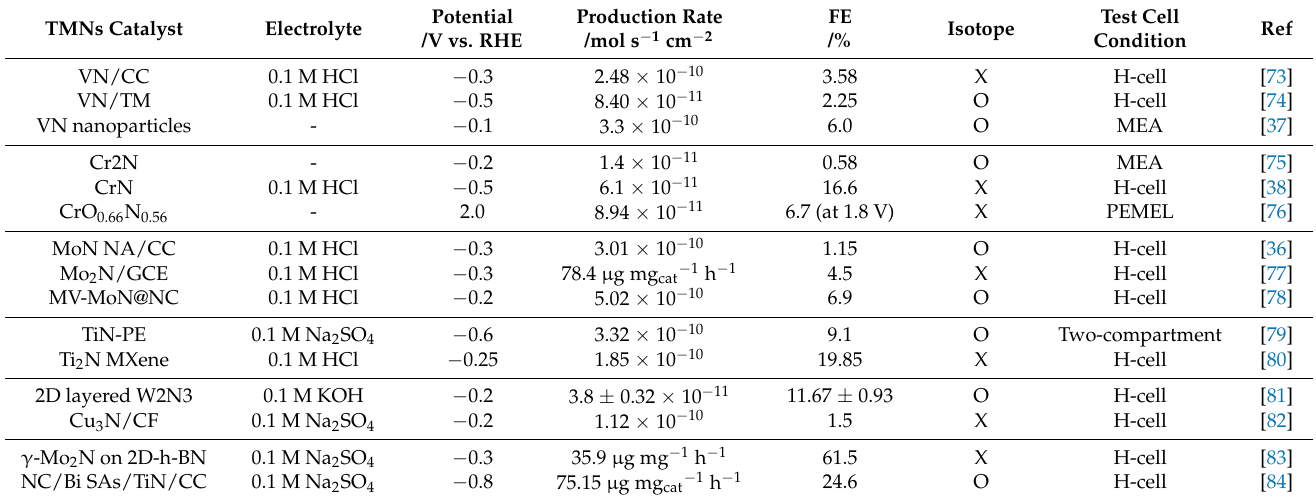
Table 1. The NRR performances of TMN-based